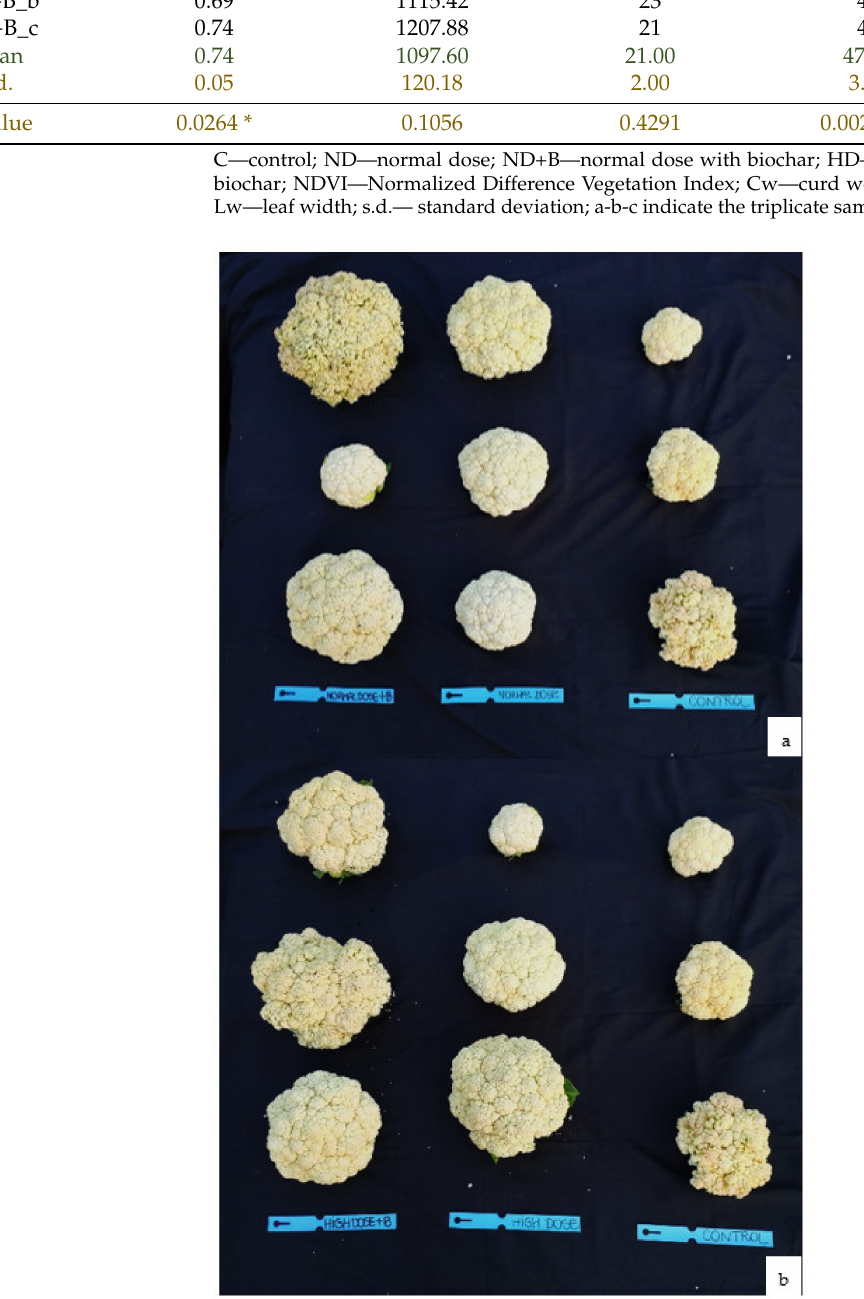
Figure 5. Cauliflower curd at the end of the vegetative growing season for the treatment with ( a ) a normal dose of N fertilizer (130 kg N ha − 1 ) with and without biochar, and in comparison to the control, and ( b ) a high dose of N fertilizer (260 kg N ha − 1 ) with and without biochar, and in comparison to the control. Each treatments type was conducted in